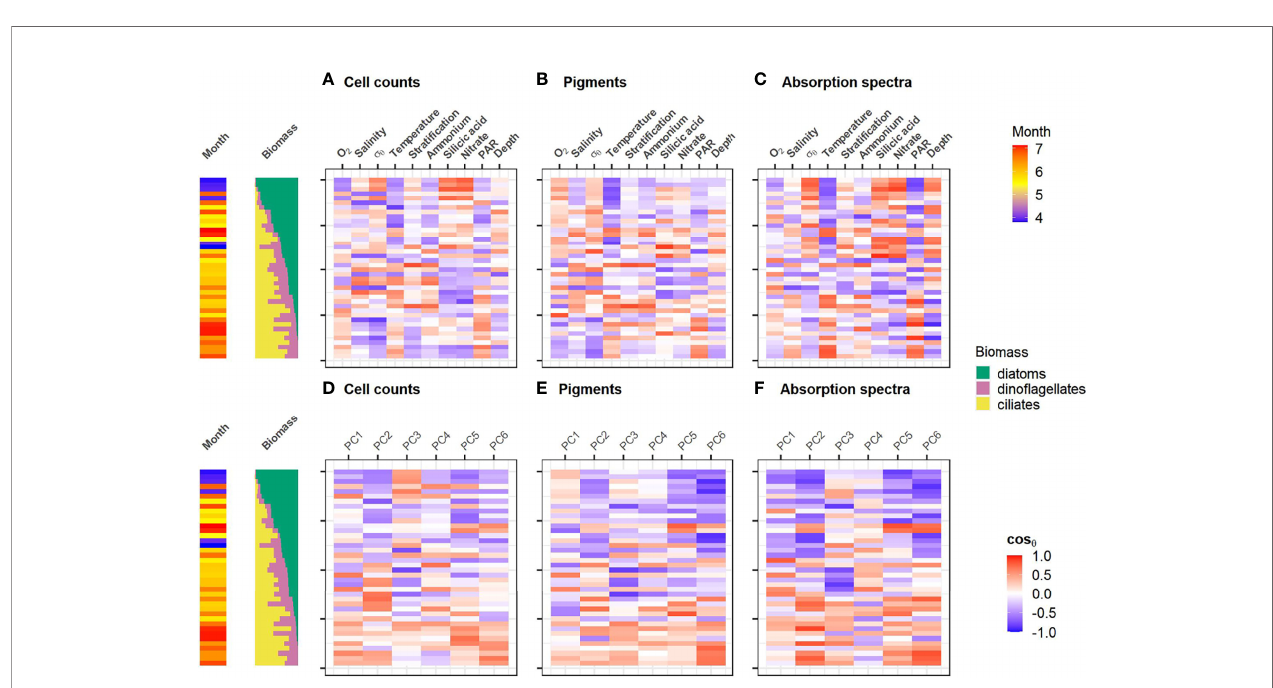
FIGURE 4 | Cos q matrices computed from Redundancy Analysis (RDA), relating phytoplankton cell counts, pigments and absorption spectra to explanatory variables – (A – C) , and by decomposed axes – (D – F) (higher axes that do not signi fi cantly explain variance in community composition are omitted; see Figure S2 for full Figure). Samples are ordered by diatom contribution to microphytoplankton biomass to provide an intuitive impression of environmental dependencies across the samples. Differing gradients, for example over silicic acid concentration between cell counts and pigments, demonstrate that salient environmental dependencies across the phytoplankton samples depend on data type. PAR, ‘ Photosynthetically Available Radiation ’ . Depth: depth of sample. s q : potential density. Strati fi cation: depth of maximum buoyancy